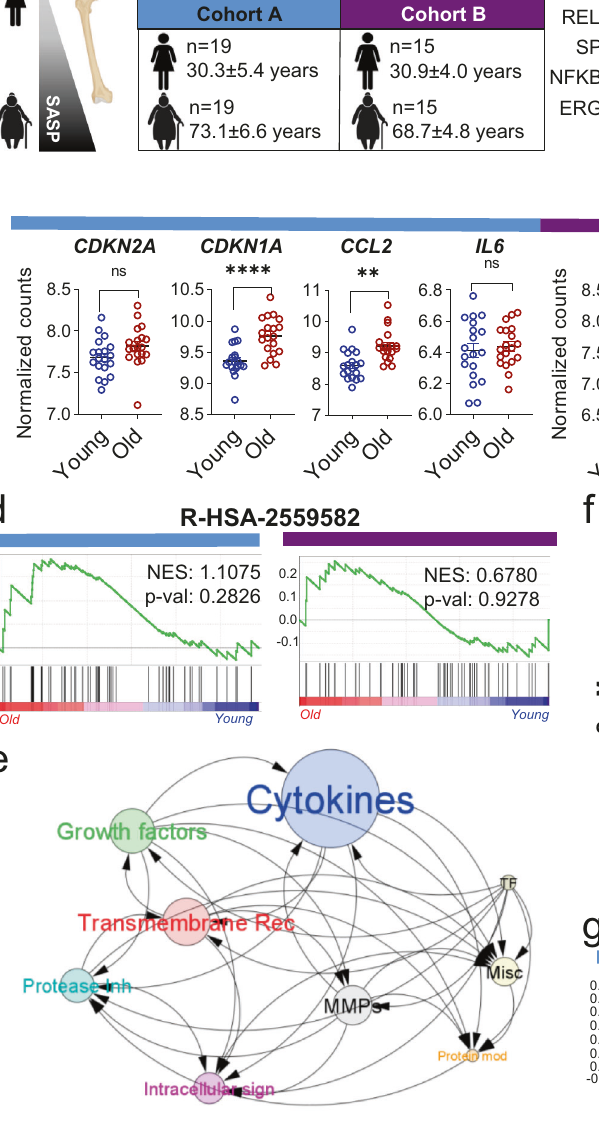
in either human cohort. Nominal p value, calculated as two-sided t-test, no adjustment since only one gene set was tested; e The SenMayo gene set includes growth factors, transmembrane receptors, and cytokines/chemokines that are highly in fl uenced by other members of the gene set. The circle size depicts groupwiseinteractions,arrowspointthedirectionoftheseinteractions. f SenMayo encodes a dense network of nine different protein classes within a strong interac- tion network. The size of each circle represents the connectivity with other mem- bers of the gene set, grey lines represent interactions 92 ; g Genes included in the SenMayo gene set were signi fi cantly enriched with aging in both human cohorts. Nominal p value, calculated as two-sided t -test, no adjustment since only one gene set was tested CohortA: n =38(19 young, 19 old,all ♀ ),Cohort B: n =30 (15 young, 15 old, all ♀ ). ** p <0.01, **** p <0.0001. Fig. 1a was designed using Biorender.com. Depicted are mean±SEM. Source data are provided as a Source Data fi